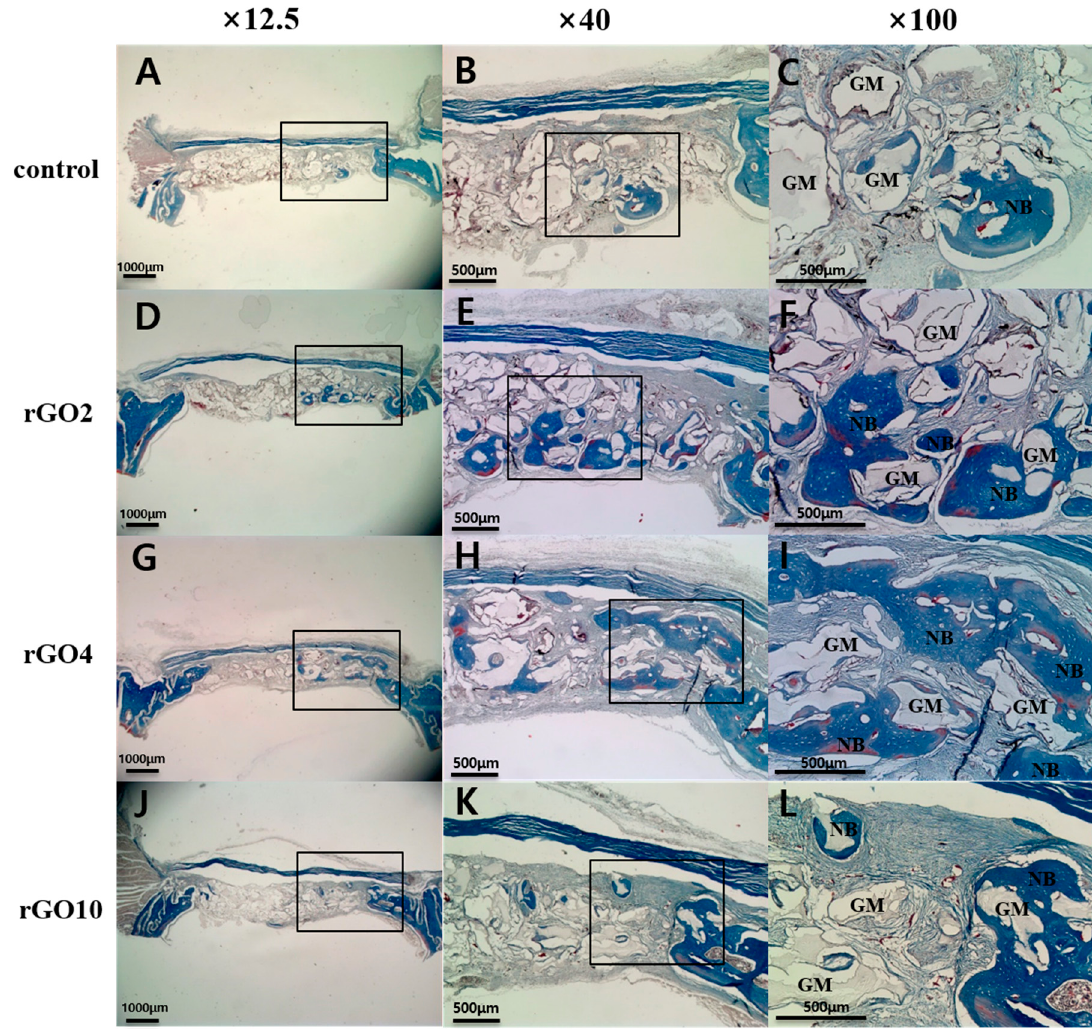
Figure 8. Histological view of Masson’s trichrome stained sections at 8 weeks after surgery. Black box is the area of interest. ( A – C ) Control group; ( D – F ) rGO2 group; ( G – I ) rGO4 group; ( J – L ) rGO10 group; OB: old bone, NB: new bone, GM: bone graft material (Original magnifications: 12.5× ( A , D , G , J ), 40× ( B , E , H , K ), 100× ( C , F , I , L )).